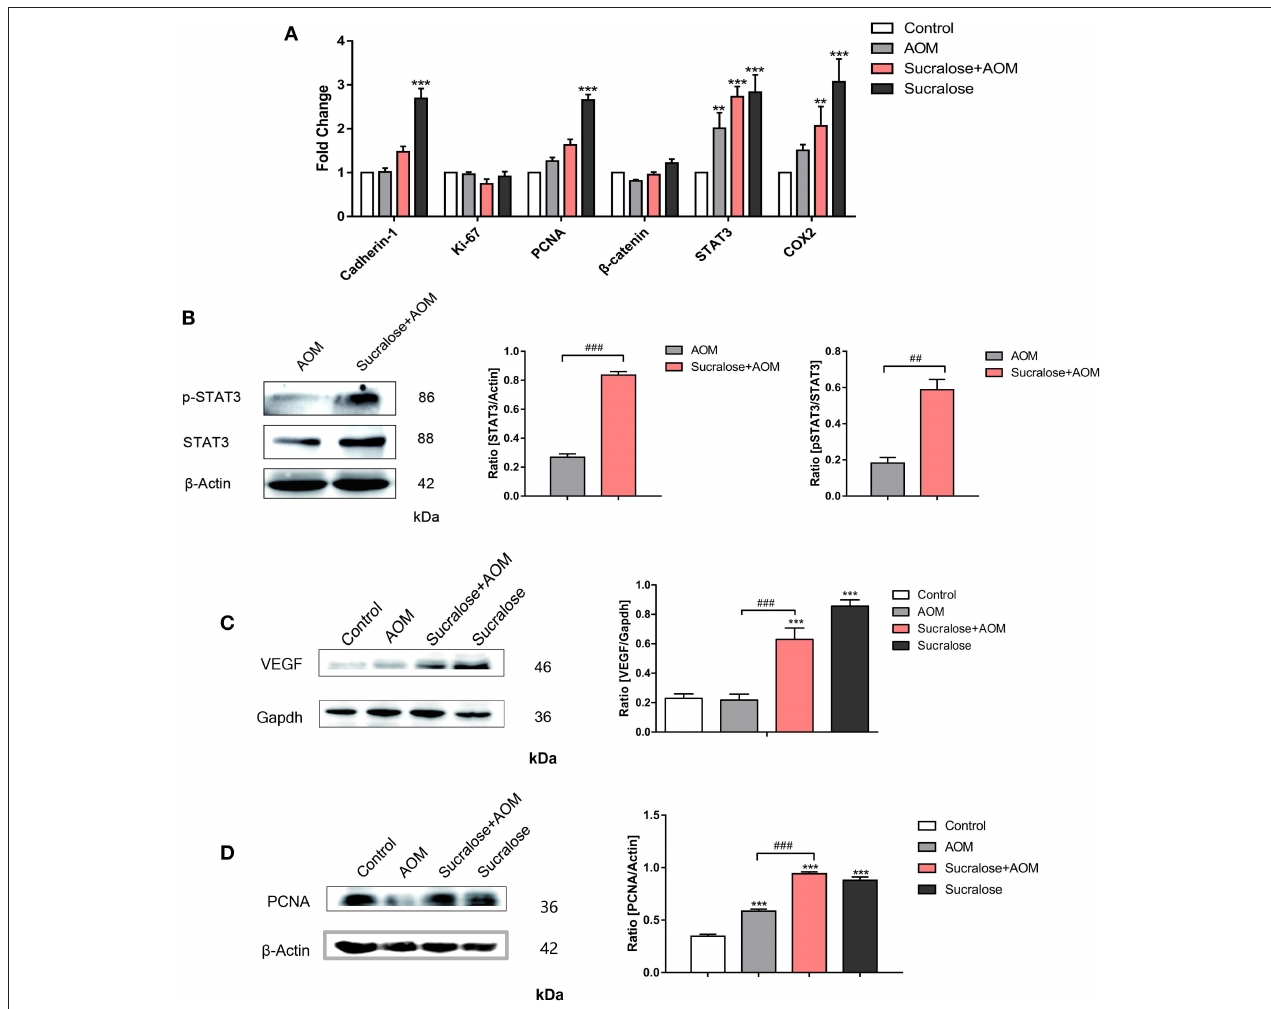
FIGURE 6 | Sucralose promotes tumor-associated gene expression. (A) mRNA levels of tumor-associated genes. (B) Changes in STAT3 and pSTAT3 in tumor tissues. (C) Changes in VEGF protein in colon tissue. (D) Expression of PCNA protein in colon tissues. Compared with the control group: ** P < 0.01, *** P < 0.001; compared with the AOM group: ## P < 0.01, ### P < 0.001, n =